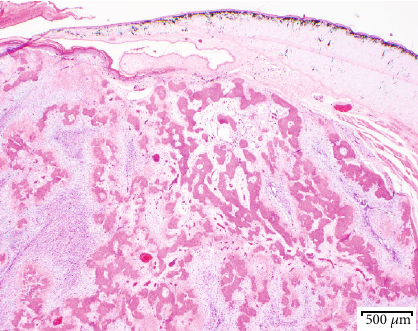
Figure 6: Massasauga rattlesnake ( Sistrurus catenatus ). Low- magni fi cation (20x) photomicrograph of a dermal osteosarcoma composed of a well-demarcated, expansile mass of haphazardly arranged spindle cells interspersed between irregular islands of bone and myxomatous